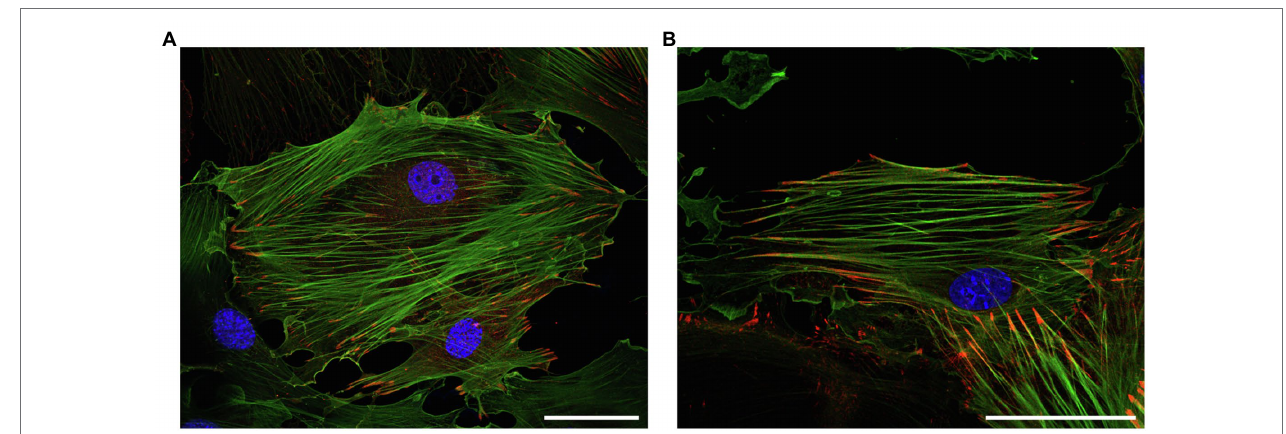
FIGURE 3 | Representative immunofluorescence analysis of the intracellular localization of (top) LPP and (bottom) zyxin in cultured vascular SMC isolated from the aorta of 3-month old C57BL/6 wildtype mice. The vascular SMC (passage 3) were seeded directly on microscopic slides, fixed with p -formaldehyde, and stained for LPP or zyxin with a corresponding anti-LPP (HPA017342) or anti-zyxin (HPA004835) primary antibody at a dilution of 1:75 together with a primary anti- α -smooth muscle actin ( α -SMA, F3777, all Sigma-Aldrich) at a dilution of 1:200. Images were recorded using a Leica TCS SP8 laser scanning confocal microscope. Both proteins (red fluorescence) mainly localize to the interface between FA and the (tips of the) cortical actin cytoskeleton, which is chiefly organized in stress fibers indicative of a mainly quiescent contractile phenotype of the cultured vascular SMC. The nuclei were counterstained with DAPI (blue fluorescence). The size marker corresponds to 50 μ